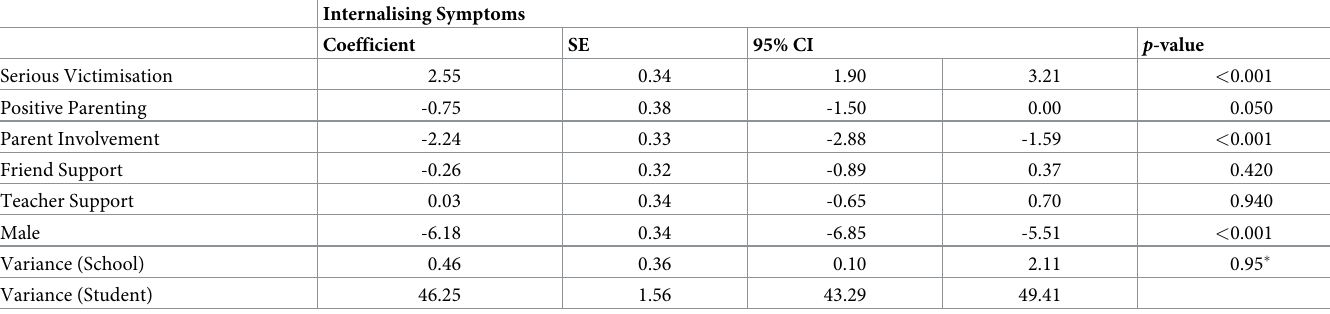
Table 7. Linear mixed-effects models of serious victimisation & all sources of social support (weighted).